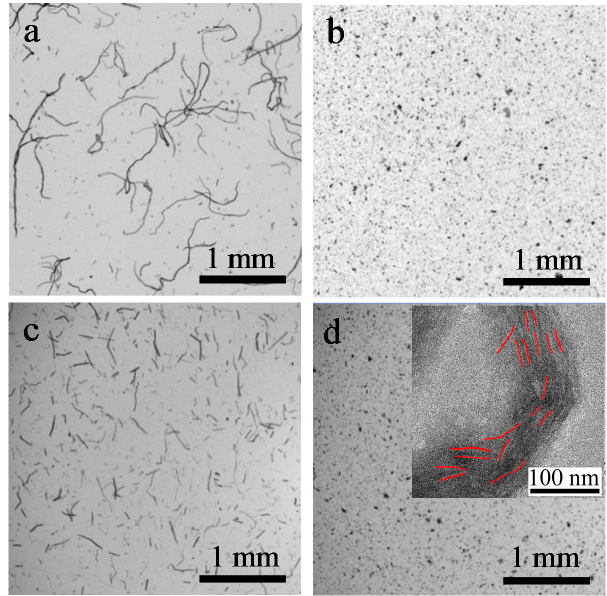
Figure 6. Optical microphotographs of ( a ) pristine cellulose; ( b ) NaOH/urea-treated cellulose; ( c ) direct TEMPO-oxidized cellulose; and ( d ) NaOH/urea-treated TEMPO-oxidized cellulose. Inset in (d) is the TEM image of NaOH/urea-treated TEMPO-oxidized cellulose.